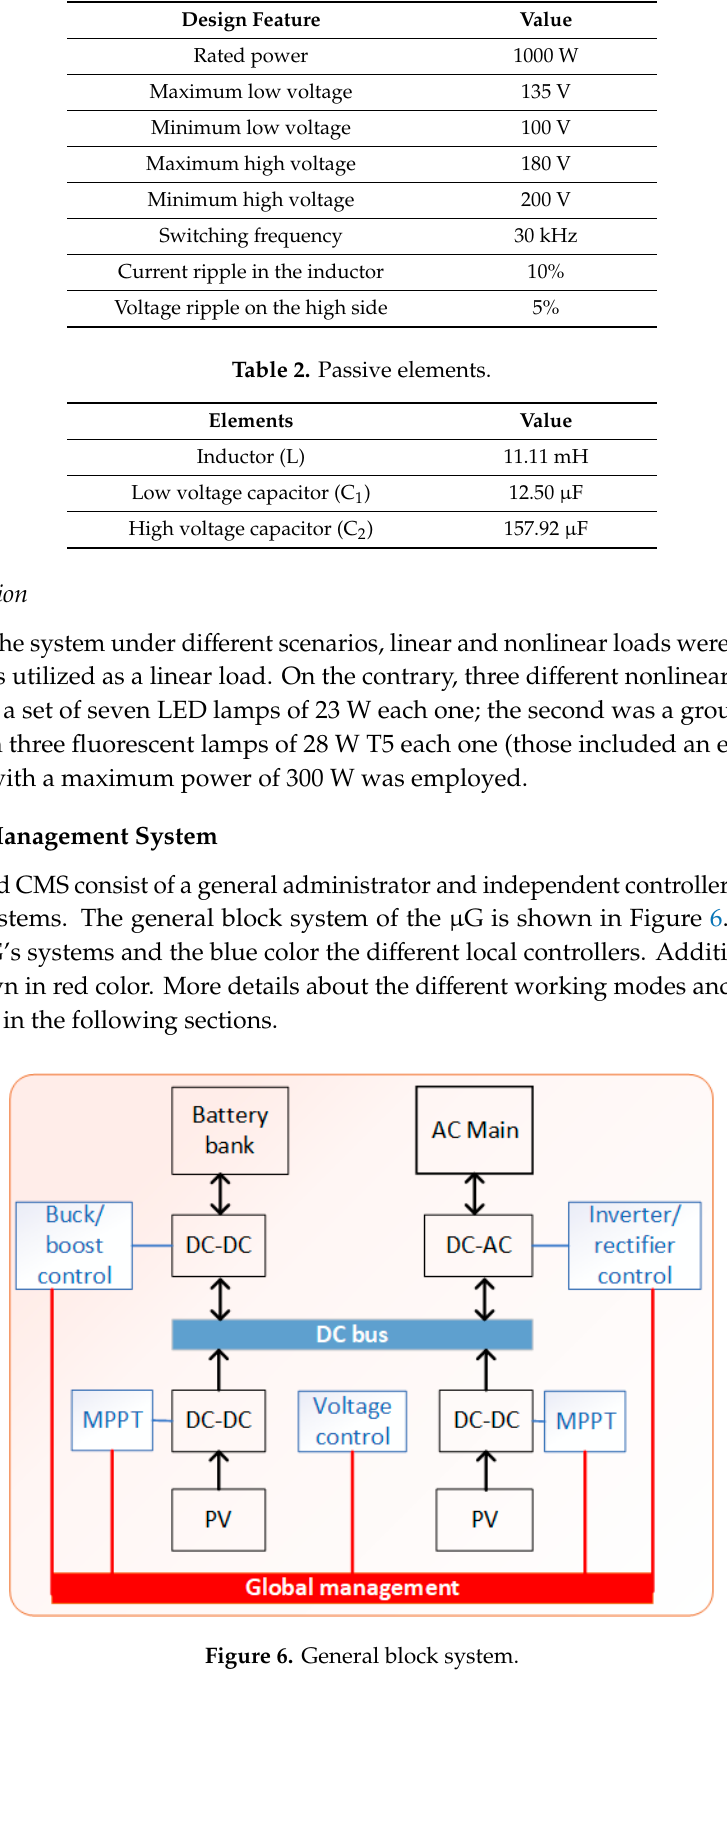
Table 1. Bidirectional DC–DC converter parameters.